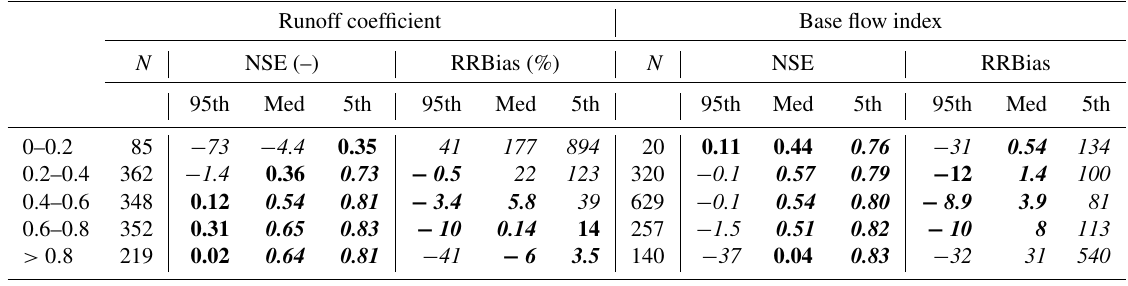
Table 4. Summary statistics of DECIPHeR performance metrics for GB, with catchments grouped by runoff coefficient and base flow index. Percentiles are taken from the behavioural ensemble from all catchments within each group. The column N indicates the number of catchments in each group. Cells are formatted in typeface according to the thresholds outlined in Sect. 4.3.3: bold italic for the stricter threshold, bold for the weaker threshold and italic where it does not meet either of the thresholds.